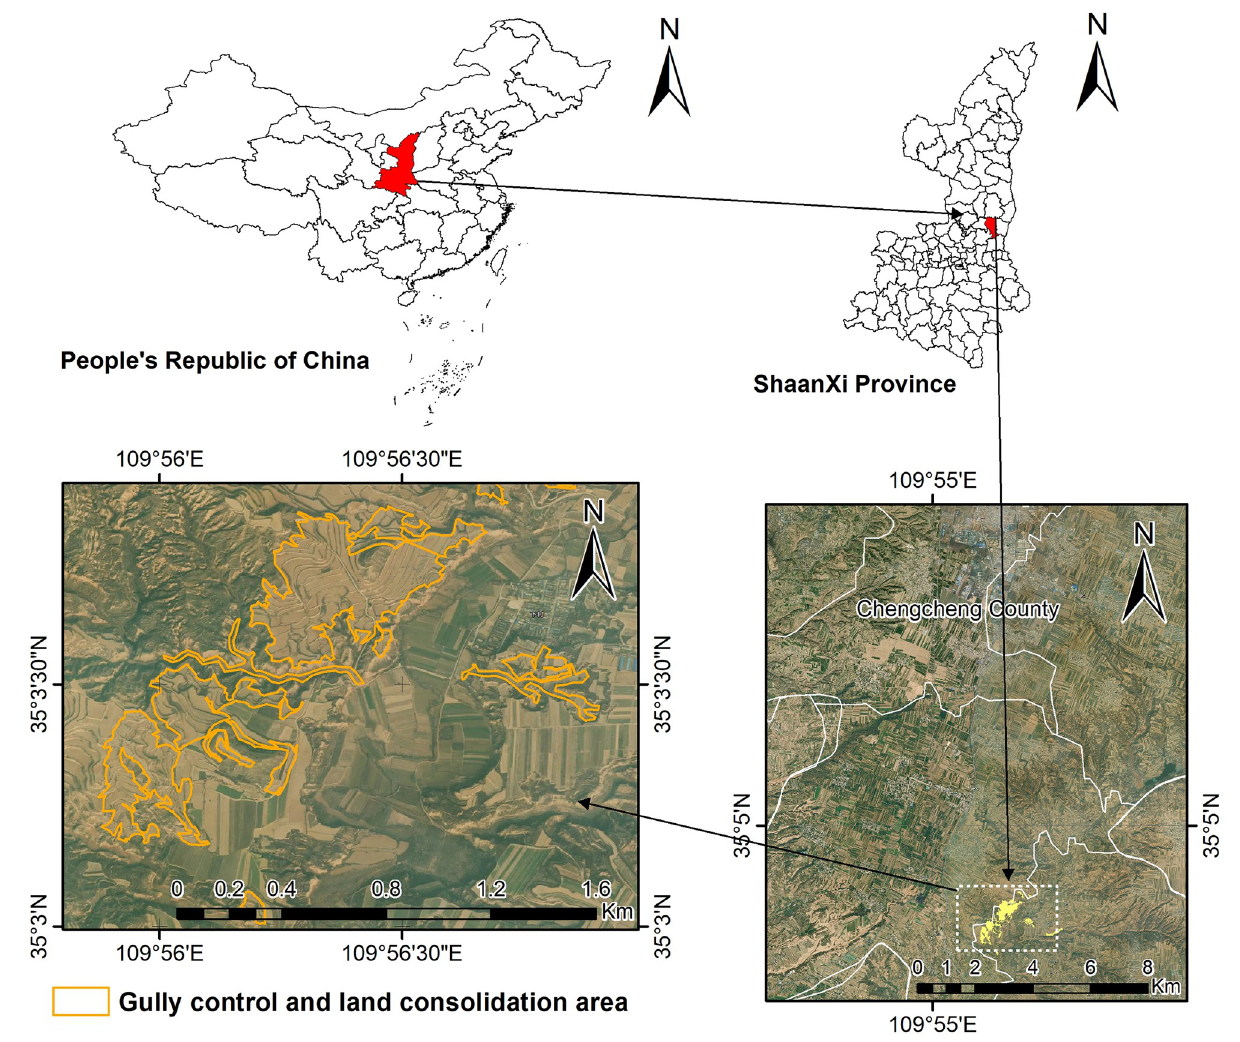
Fig 1. Geographical location of the target area. Source: USGS Earth Resources Observatory and Science Center (https://www.usgs.gov/centers/eros).